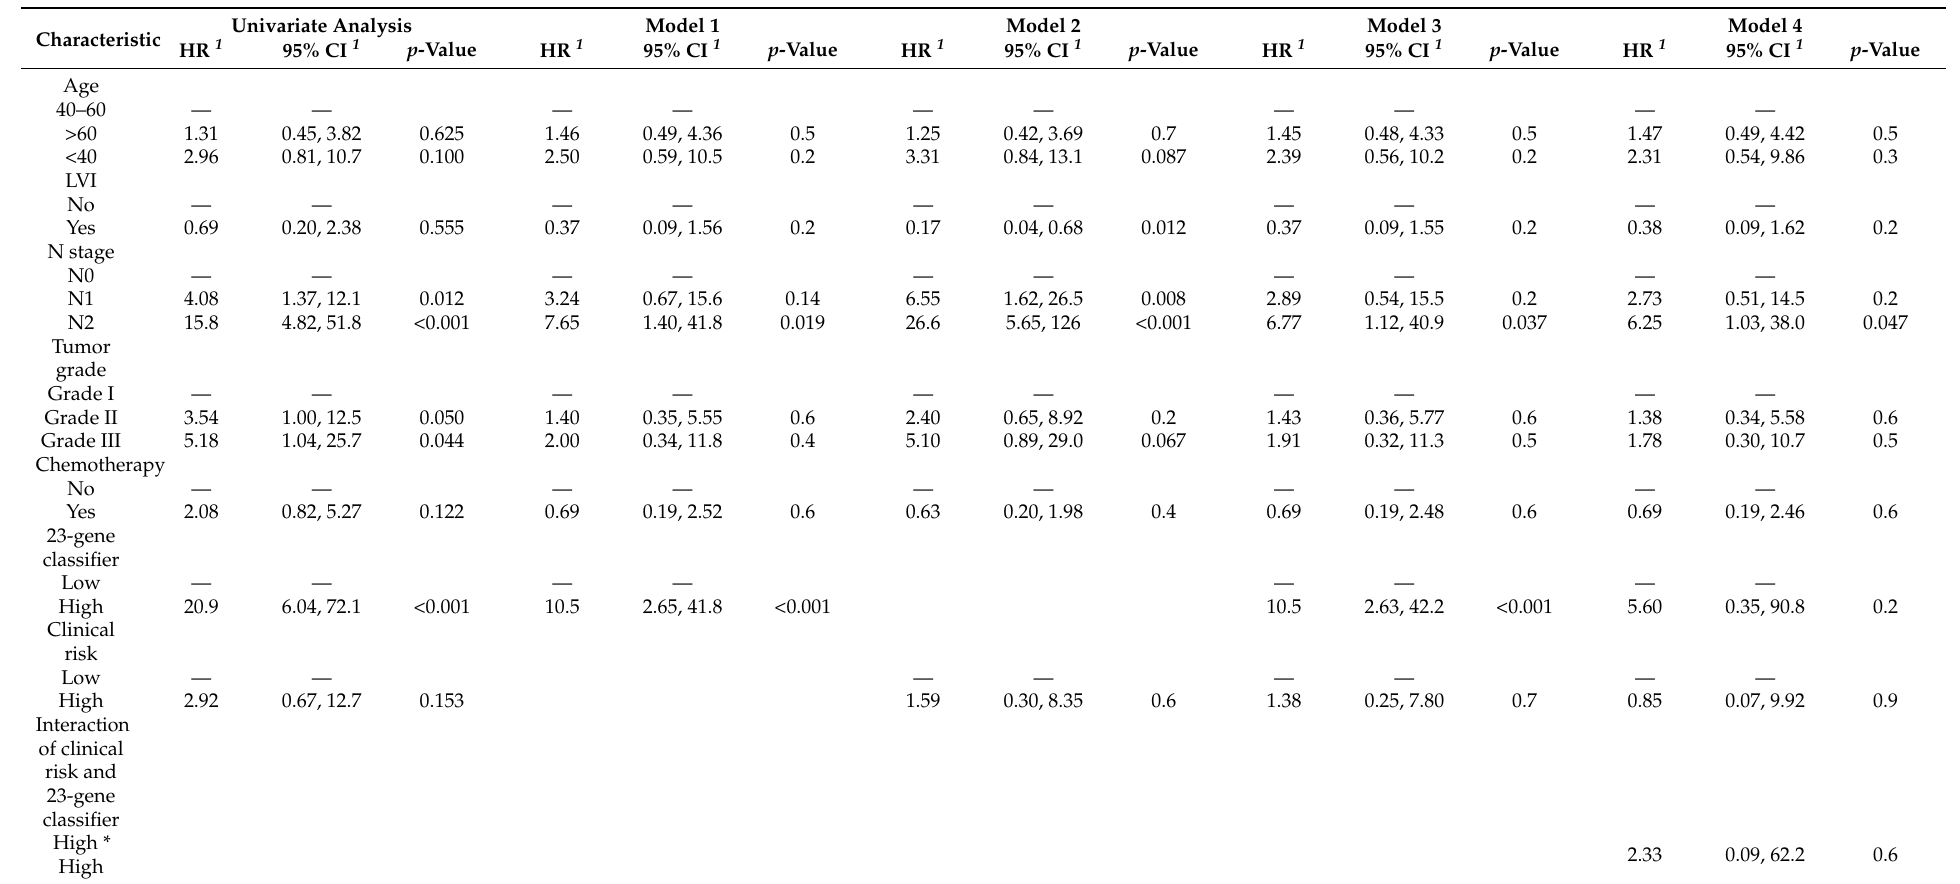
Table 6. Cox proportional hazards regression for RFI within 5